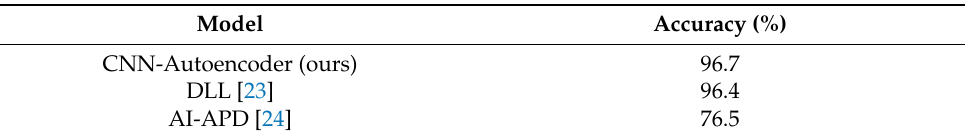
Table 4. Accuracy comparison for the proposed model and previously published studies on colon polyp